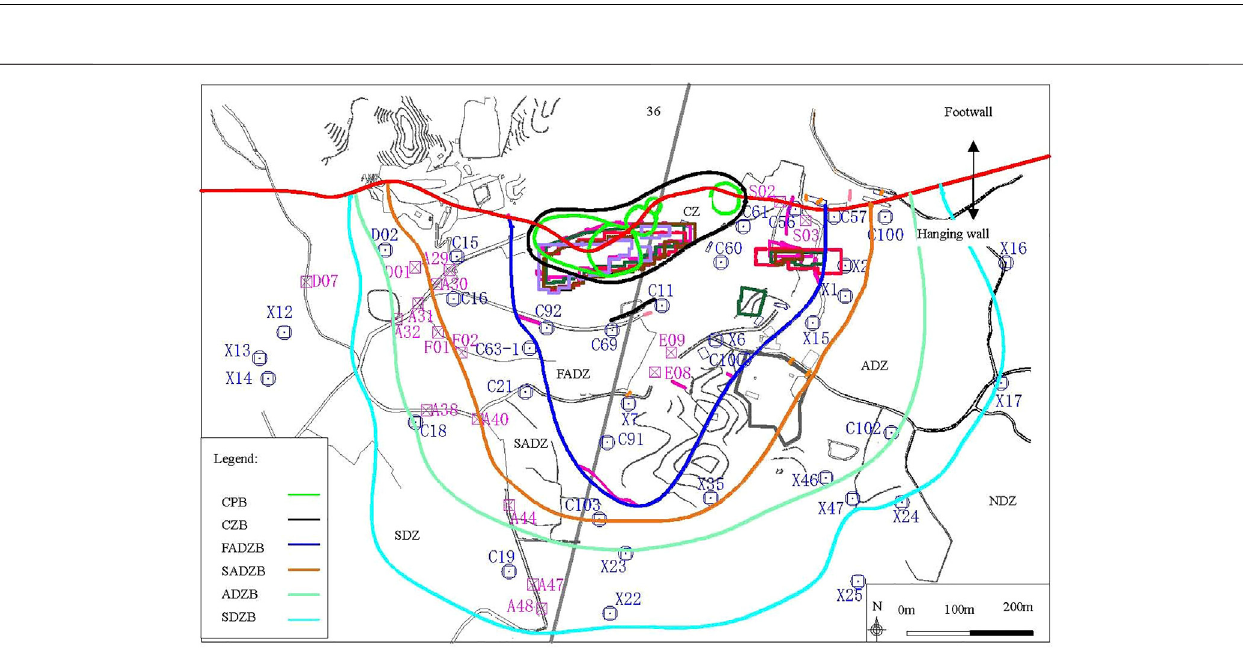
FIGURE 11 | The zones formed on the ground surface.